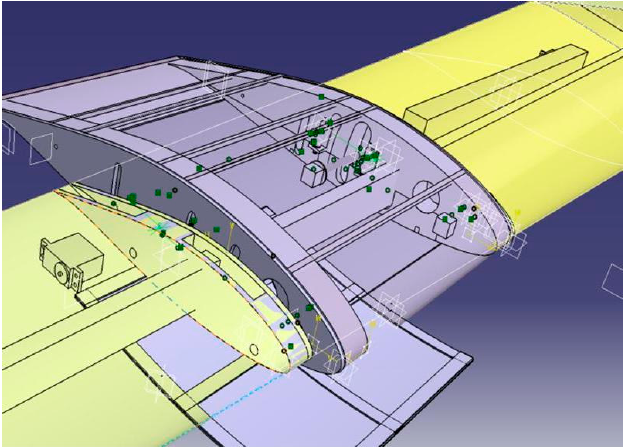
Figure 7. CAD design of wing glove. (Reprinted by permission of the American Institute of Aeronautics and Astronautics, Inc. (Reston, VA, USA) from [37]).